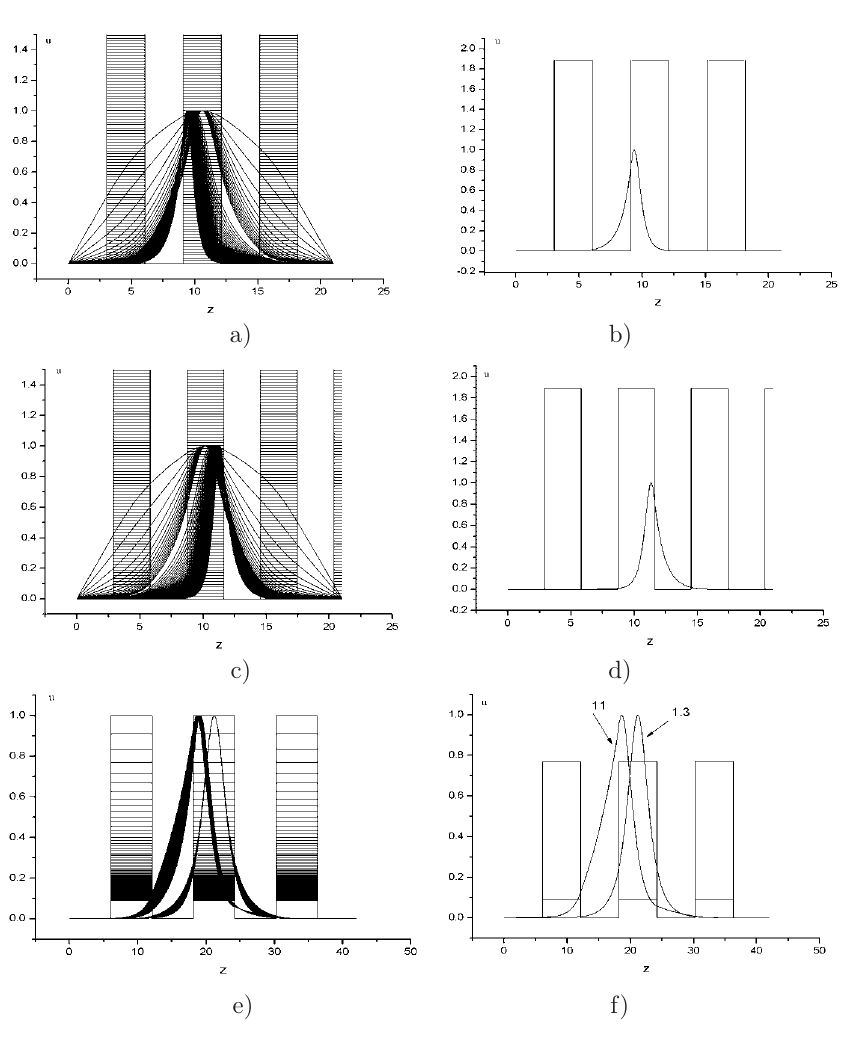
Figure 4. Jump of soliton position at increasing of | α 2 | from 0 to 40 (a-d) for Ω = 1 / ( 4 π ) , ε 1 = 1 . 69 ,ε 2 = 5 . 29 ,α 1 = 0 , L = 21 at small changing of layers thickness from d 1 = d 2 = 3 . 0 (a, b) to d 1 = d 2 = 2 . 9 (c-d) or jump of soliton position at increasing of ε 2 from 1.3 to 11 (e-f) for Ω = 1 / ( 4 π ) , ε 1 = 1 ,α 1 = 0 ,α 2 = − 4 , L = 42 ,d 1 = d 2 = 6 . 0 (e-f). A width of EF decreases with increasing of | α 2 | . Areas with horizontal lines correspond to nonlinear layers of a photonic crystal. Final soliton profile for maximum value | α 2 | or ε 2 is depicted on Fig. 4b, 4d ,